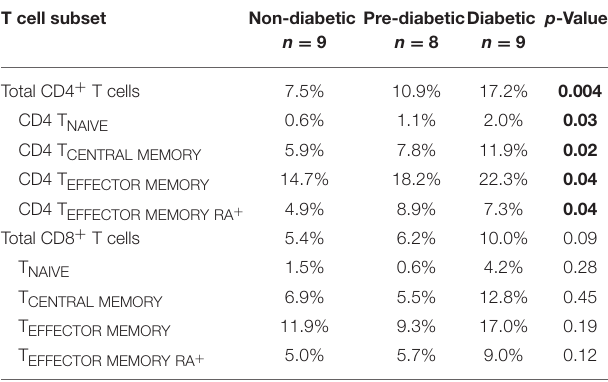
TABLE 3 | Mean SAT CD4 + and CD8 + T cell CD69 expression according to glucose tolerance. T cell